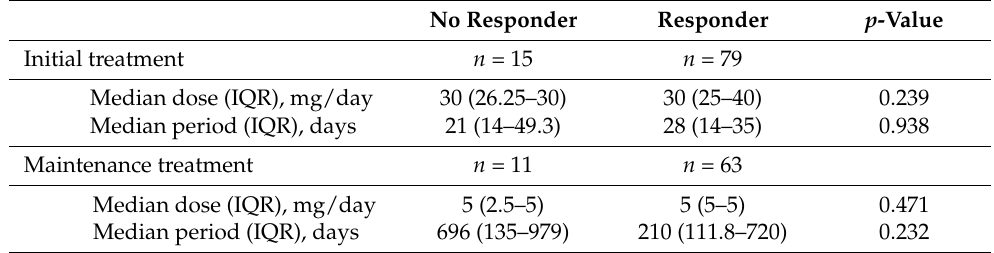
Table 3. Contents of glucocorticoid therapy.